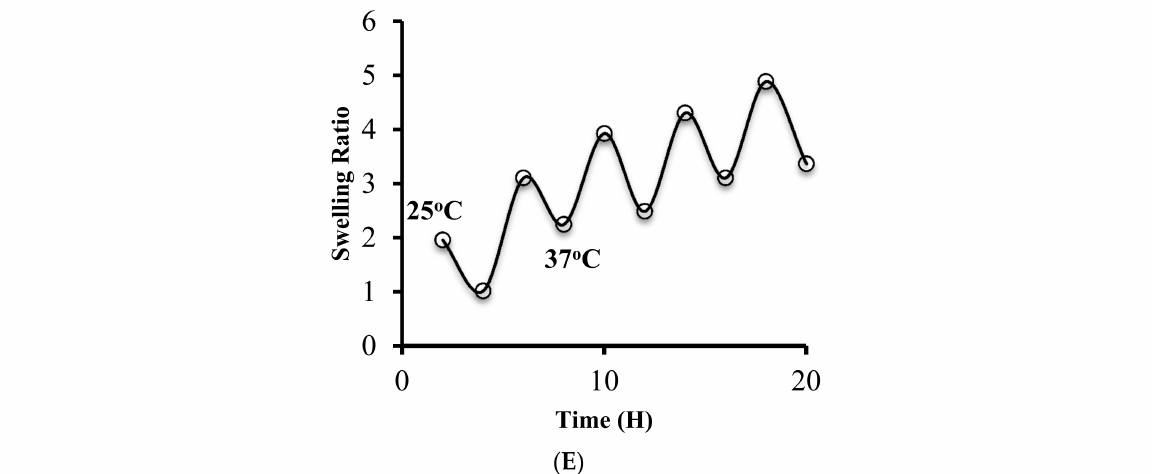
Figure 9. The response of chemically grafted Poly (NVCL-g-NaAlg) in situ depot gels to swelling media of variable pH values at constant temperature i.e., 25 ◦ C. A significant difference was seen in data at pH = 7.4 and 1.2. The data were analyzed with one-way ANOVA and found significant with p -value of <0.001 ( A ) Response of chemically grafted Poly (NVCL-g-NaAlg) in situ thermoresponsive depot gels to equilibrium swelling at variable pH and temperature programs ( B ) Effect of variable crosslinking agent concentrations (MBA) on equilibrium swelling ratio as function of time ( C ) Effect of MBA contents on ESR of chemically grafted Poly (NVCL-g-NaAlg) in situ depot gels at different pH and temperature programs ( D ). Heating and cooling cycles (swelling-deswelling-reswelling kinetics) of chemically grafted Poly (NVCL-g-NaAlg) depot gels ( E ) The data indicate the mean